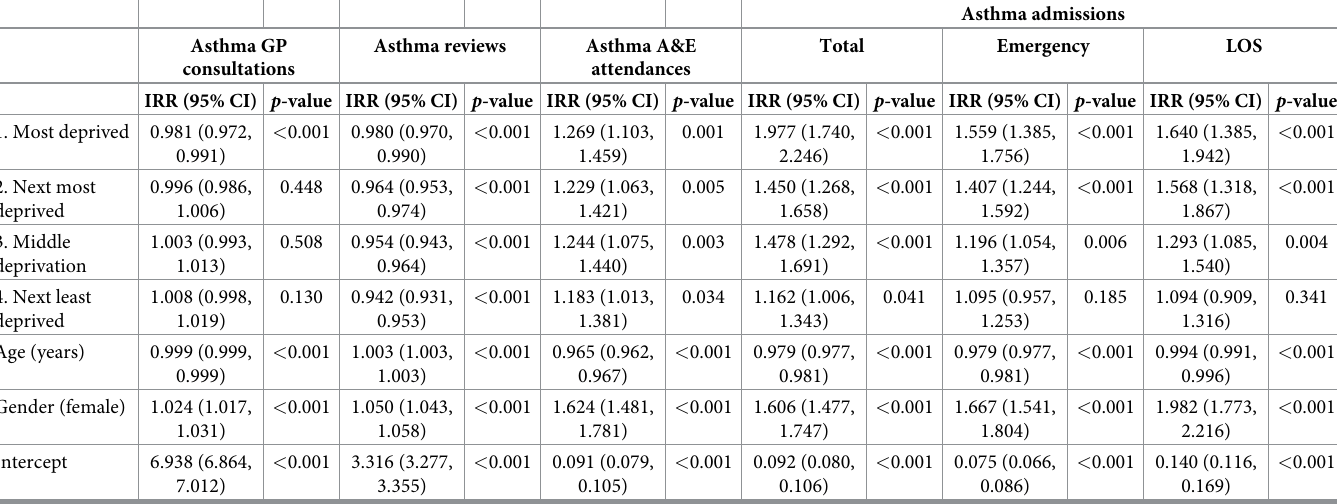
Table 3. IRRs with 95% CIs of asthma health service utilisation in each of the WIMD 2011 quintiles relative to the least deprived quintile (fifth quintile), controlled for age and gender.